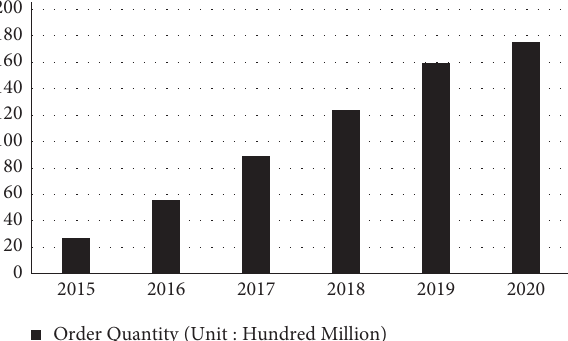
Figure 1: China’s real-time logistics order volume from 2015 to 2020. Source: iResearch